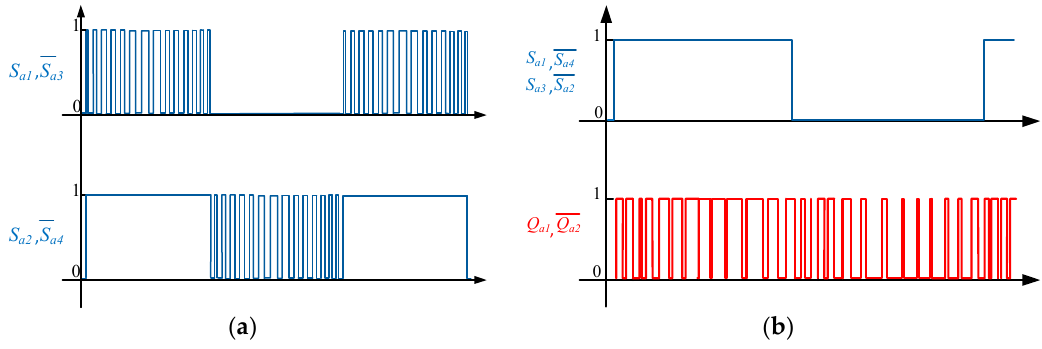
Figure 2. Switching sequence for: ( a ) conventional NPC, T-Type, and ANPC; ( b ) HANPC topologies.